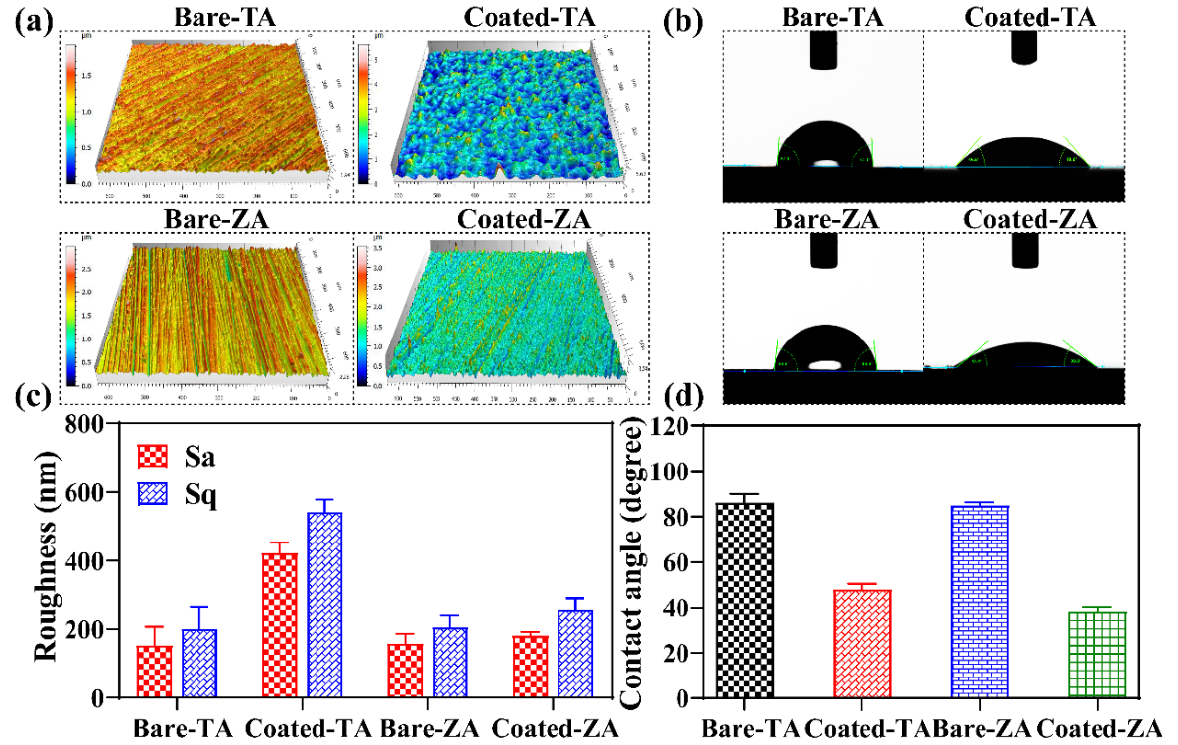
Figure 4. ( a ) LSCM 3D profile micrographs, ( b ) digital images of the water droplets, quantitative measurement results of ( c ) surface roughness, and ( d ) contact angles ( θ ) of the ZnP coatings on TA and ZA samples.